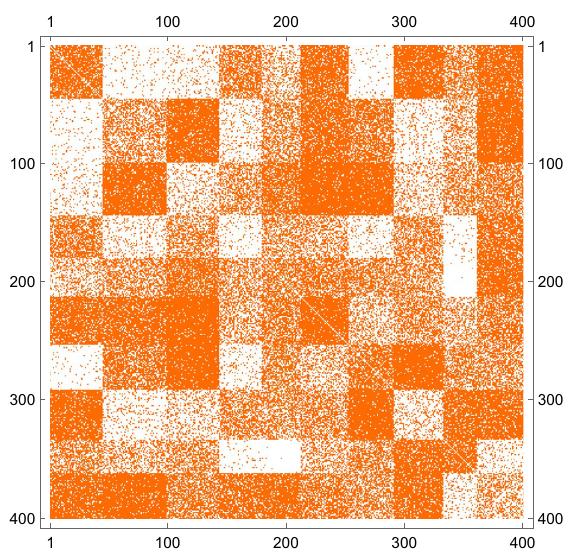
Fig. 10 Left: the true block structure. Right: the block structure found with spectral clustering. There are some large differences to be seen. In this case classifier based on the structure at right completely fails.